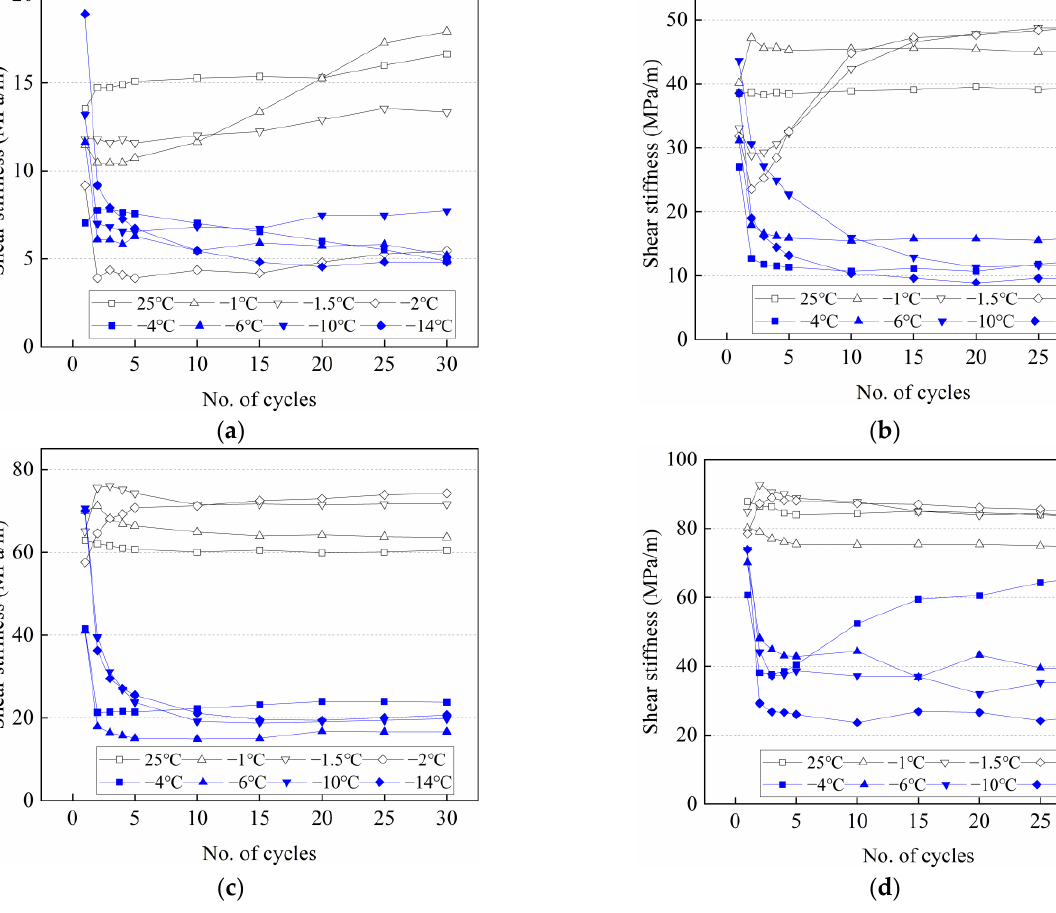
Figure 16. Variation of the shear stiffness with the number of cycles in various conditions. ( a ) 100 kPa; ( b ) 300 kPa; ( c ) 500 kPa; ( d ) 700 kPa.